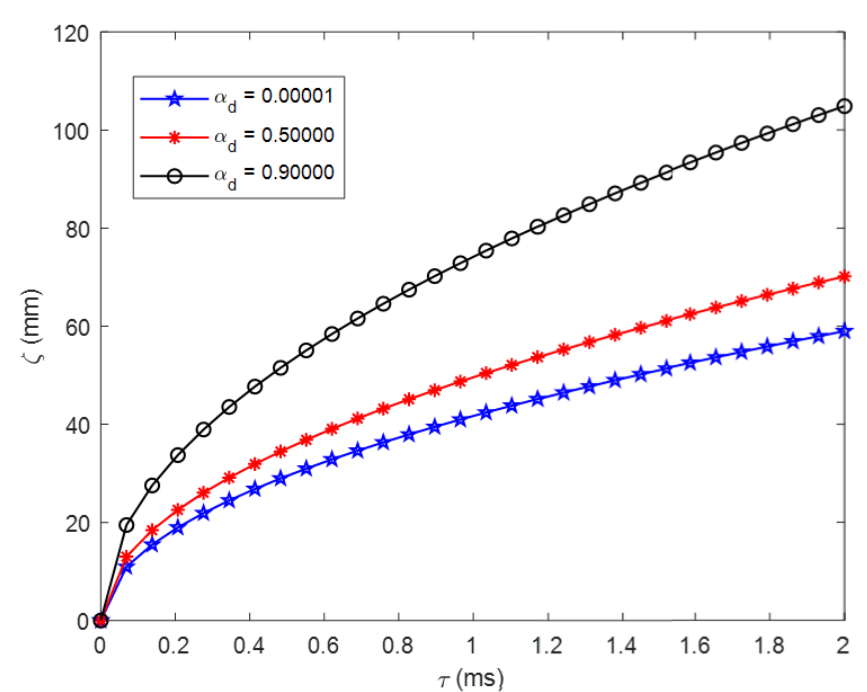
Figure 5. Effect of droplet volume